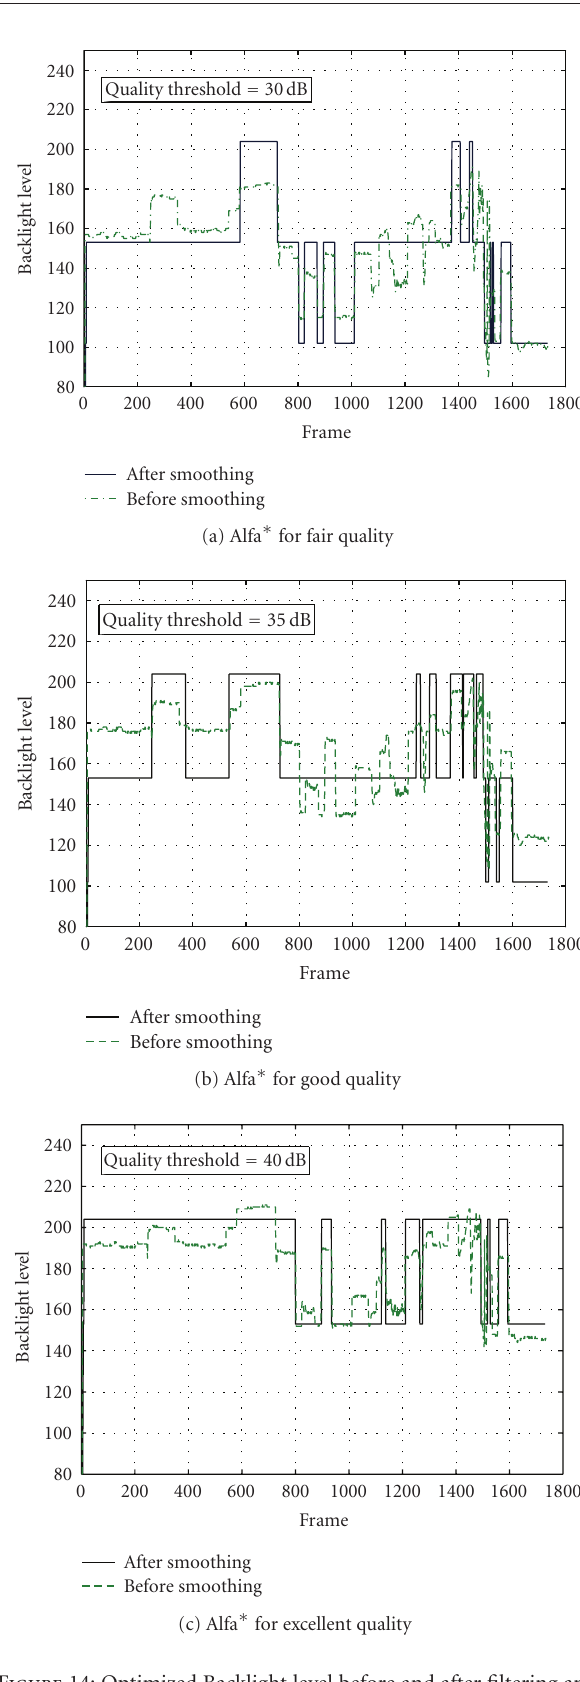
Figure 14: Optimized Backlight level before and after filtering and